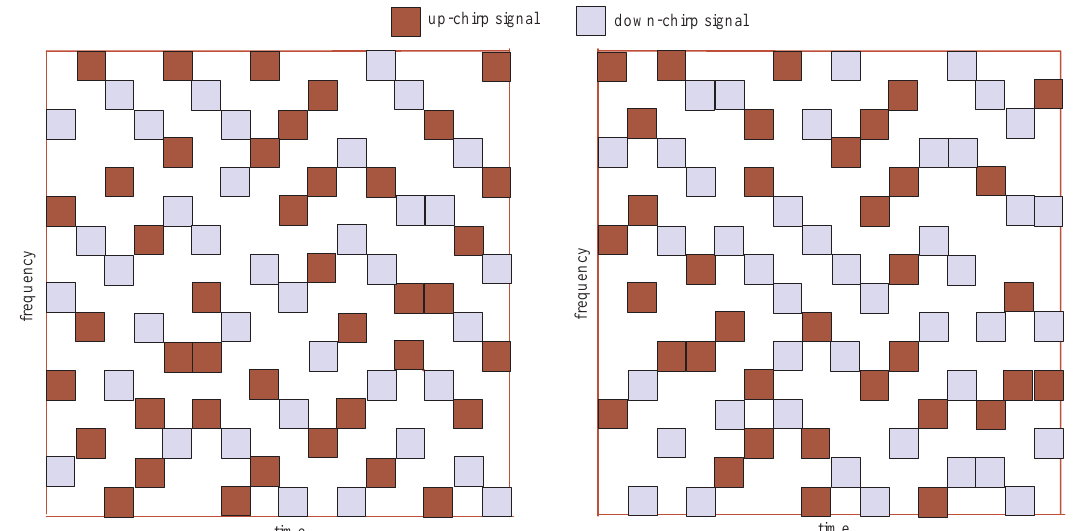
Figure 9. Illustration of orthogonal frequency division multiplexing (OFDM) chirp diverse